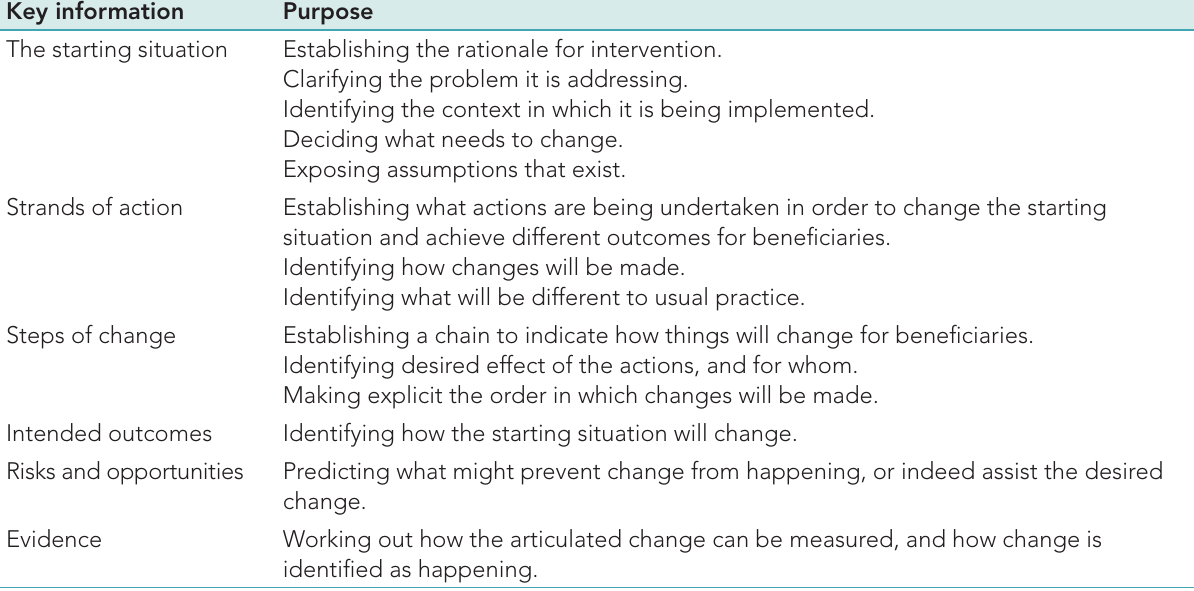
Table 1. Establishing a theory of change (Source: Author,